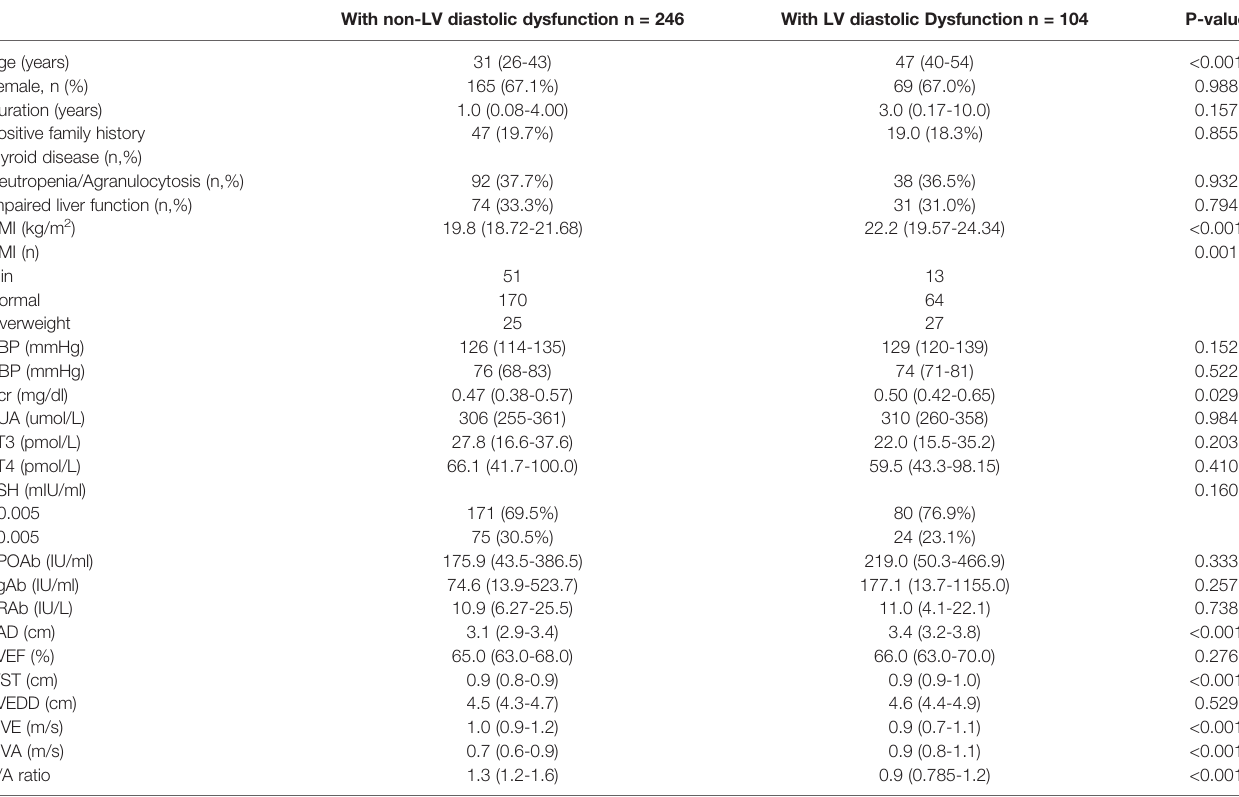
TABLE 1 | Basic characteristics and laboratory fi ndings of the overt hyperthyroid subjects with LV diastolic dysfunction. With non-LV diastolic dysfunction n =